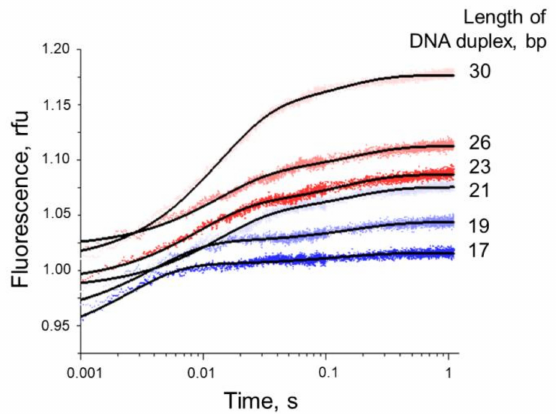
Figure 5. Kinetic curves characterising the interaction of Nt.BspD6I (1 µ M; in the presence of 10 mM CaCl 2 ) with DNA duplexes (1 µ M) of various lengths (indicated to the right of the curves). The coloured dots denote the experimental data, and each solid curve represents their fit to the equation (cid:16) (cid:17) y = C + A 1 e − k 1 x + A 2 1 − e − k 2 x (Table S2). In the presence of 10 mM MgCl 2 , similar curves were obtained (Figure